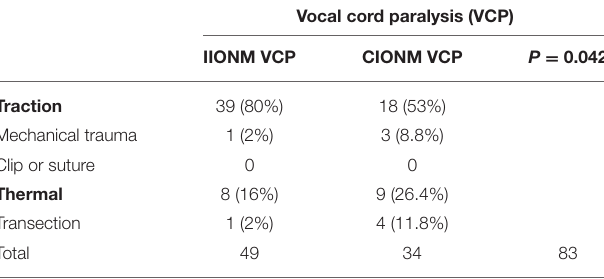
TABLE 5 | Types of mechanisms leading to RLN